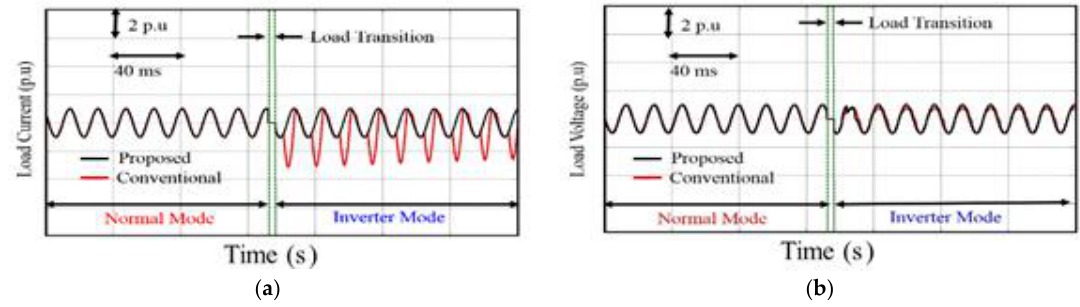
Figure 19. ( a ) Load current; and ( b ) load voltage for the conventional and proposed single-phase offline UPS topologies when the inverter voltage is injected at 210°.